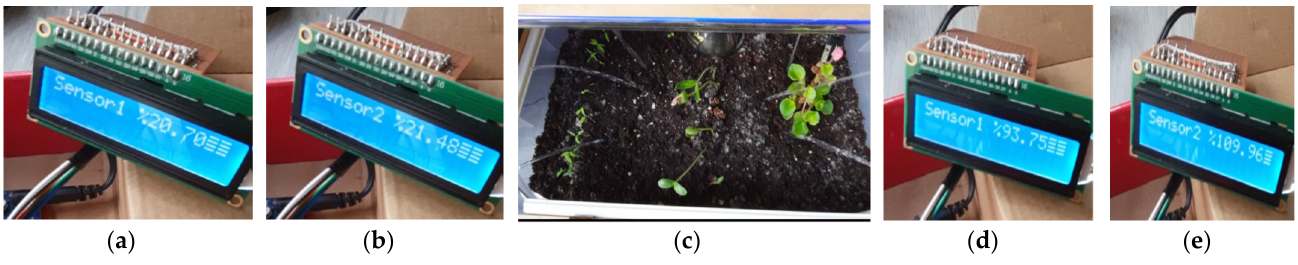
Figure 10. Displaying the values taken from soil moisture sensors on the LCD screen ( a , b ). Activated irrigation system ( c ) and values on soil moisture sensors as a result of irrigation ( d , e ).